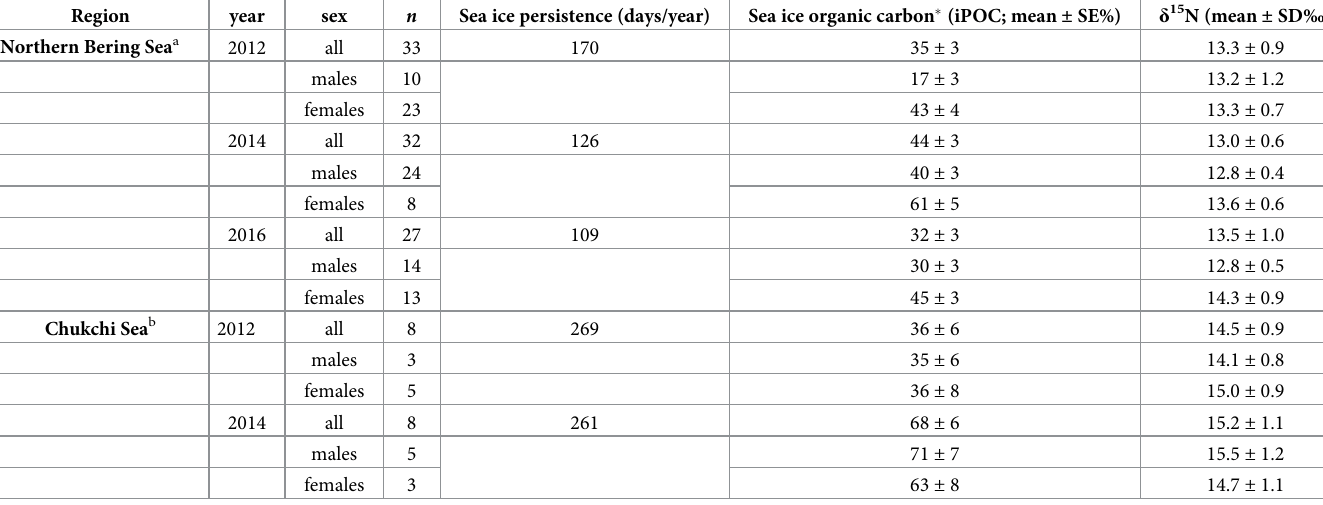
Table 1. Summary of Pacific walrus samples. The region and year of subsistence harvested Pacific walrus liver tissues with annual sample sizes ( n ) by sex. Annual sea ice persistence (days/year) associated with the year of collection and the sea ice organic carbon content (mean ± SE %) and stable nitrogen isotope composition δ 15 N (mean ± SD ‰) by sex. Mean sea ice organic carbon values were adjusted to account for a significant interaction between region and sex.